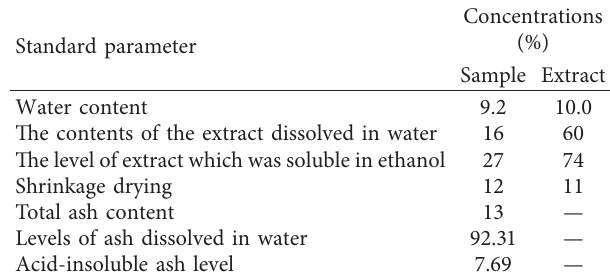
Table 2: Standard sample and extract parameters. Table 1: Phytochemical Screening of raw sample and ethanol